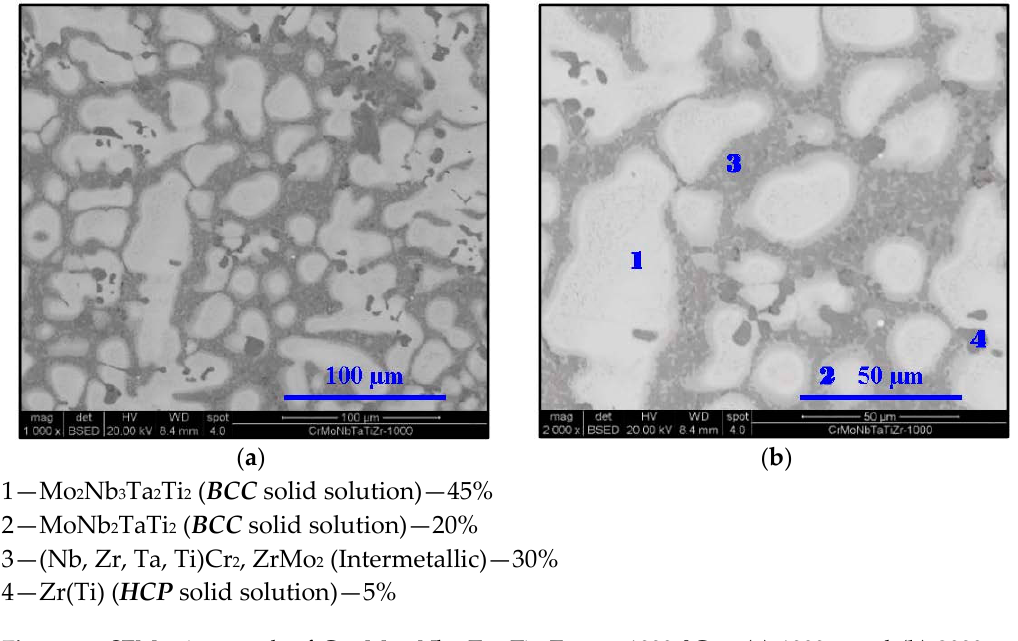
Figure 5 . SEM micrograph of Cr 20 Mo 10 Nb 20 Ta 10 Ti 20 Zr 20 at 1000 °C at ( a ) 1000× and ( b ) 2000× magnifications Figure 5. SEM micrograph of Cr 20 Mo 10 Nb 20 Ta 10 Ti 20 Zr 20 at 1000 ◦ C at ( a ) 1000 × and ( b ) 2000 × in BSE mode. magnifications in BSE mode. Materials 2018 , 11 , x FOR PEER REVIEW